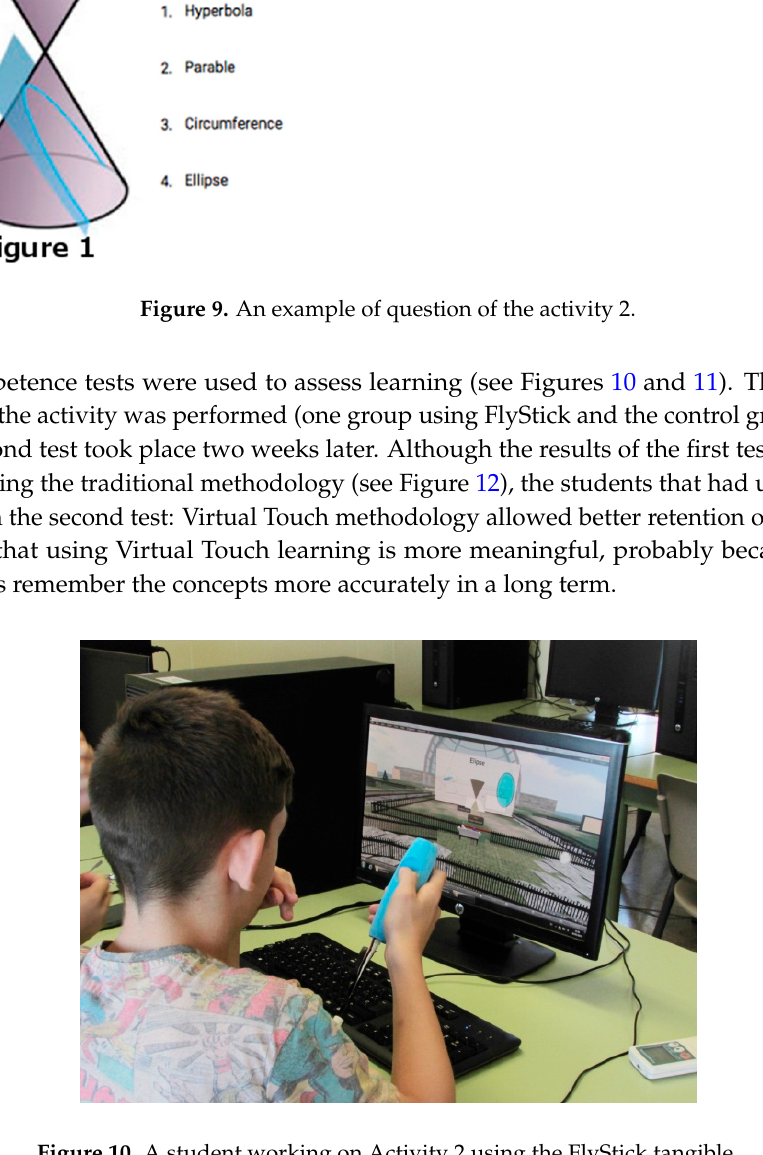
Figure 10. A student working on Activity 2 using the FlyStick tangible.